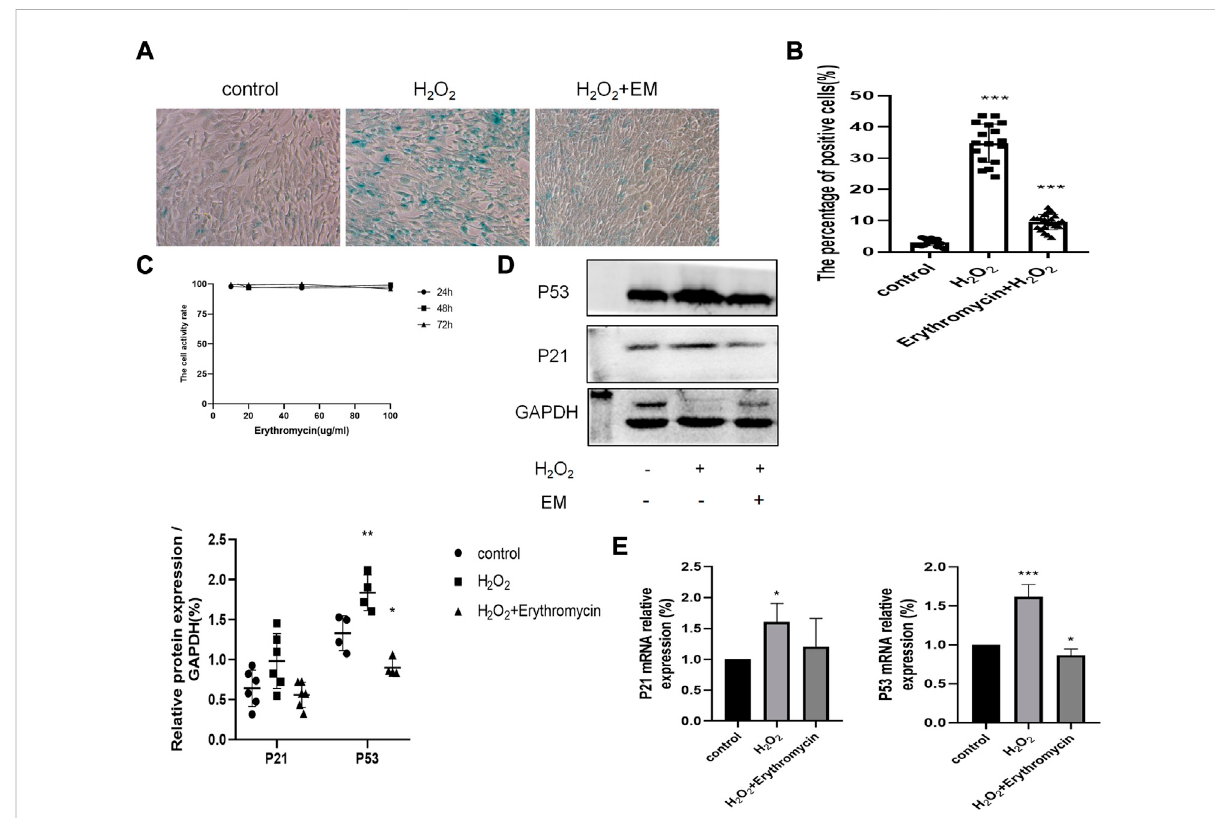
FIGURE 5 Effects of erythromycin in H 2 0 2 -treated BEAS-2B cells. (A – B) SA-13-gal staining of BEAS-2B cells treated with or without erythromycin and